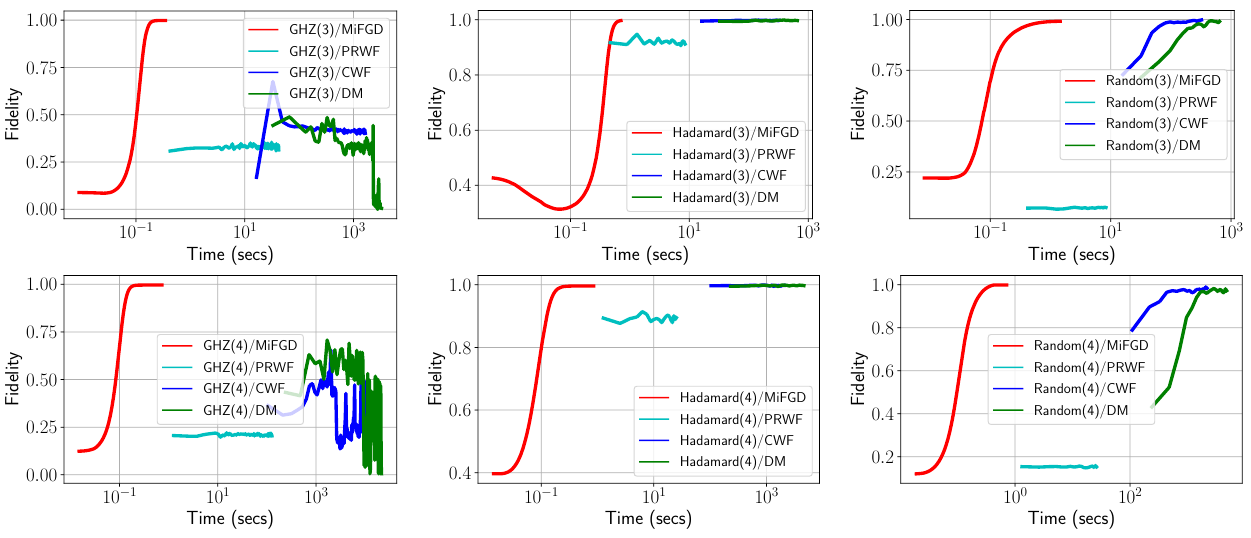
Figure 6. Fidelity versus time plots on MiFGD , PRWF , CWF , and DM , using synthetic IBM’s quantum simulator data. Left panel : GHZ ( n ) for n = 3,4; Middle panel : Hadamard ( n ) for n = 3,4; Right panel : Random ( n ) for n =